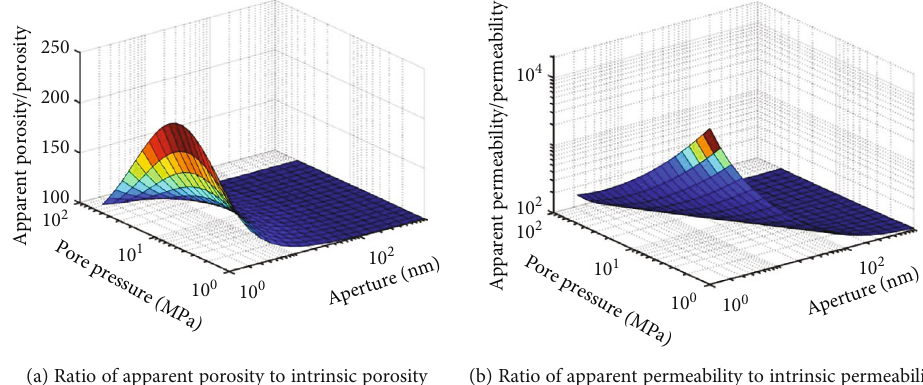
Figure 2: Comparing of apparent porosity/permeability in shales with intrinsic